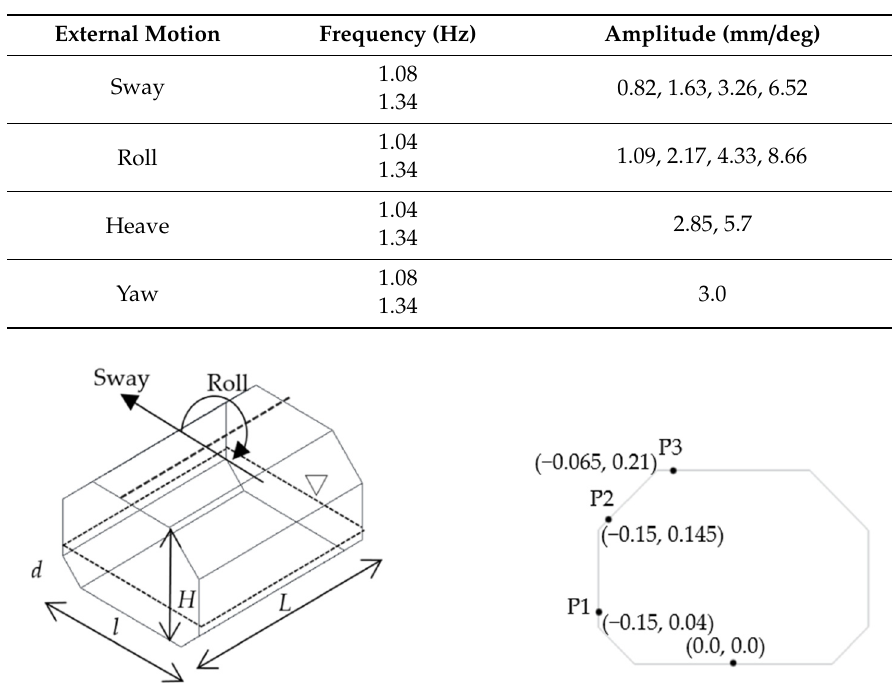
Figure 2. Geometry of the prismatic tank and locations of external gauges (units in meters). Table 2. Dimensions of the prismatic tank (units in meters).